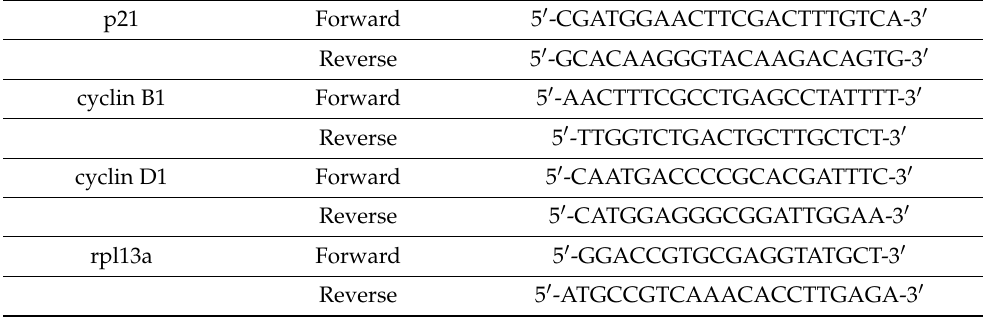
Table 2. List of primers.